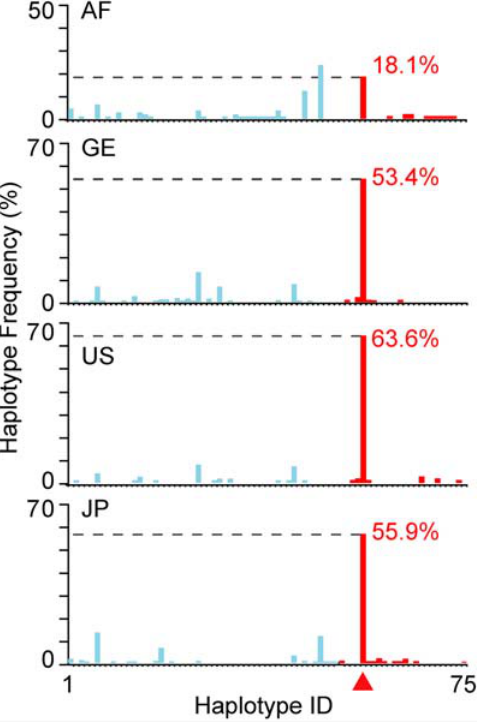
Figure 2. Haplotype frequency distribution in the four populations (refer to Figure 1 legend for abbreviations). Each haplotype is assigned into either the ancestral (HG-N; cyanine) or derived (HG-D; red) group according to its allelic status at rs1816072, likely the youngest high-D SNP. Details of the compositions and frequencies of different haplotypes are shown in Table S3.